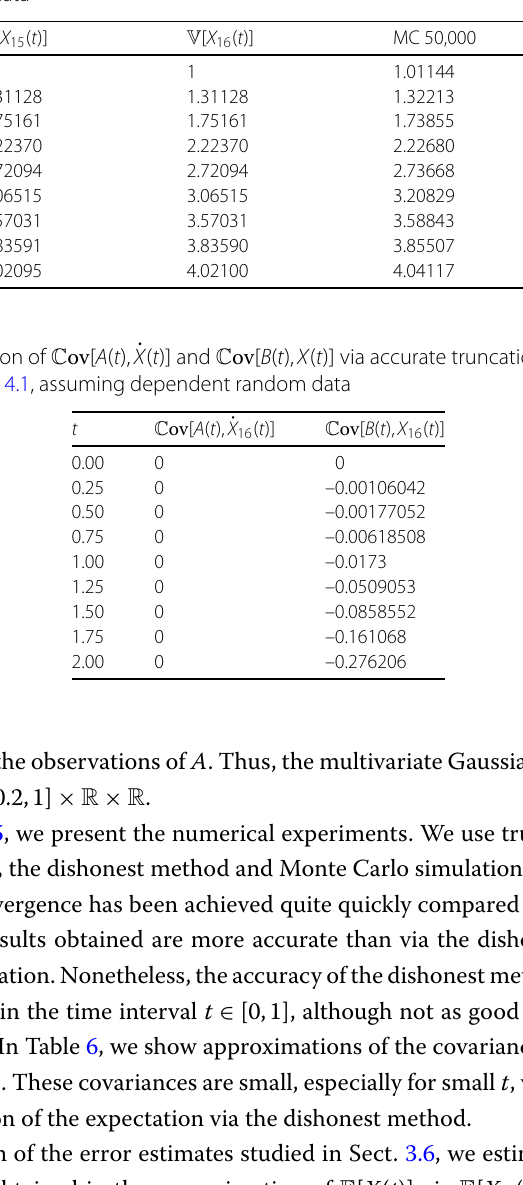
Table 5 Approximation of the variance of the solution stochastic process. Example 4.1, assuming dependent random data